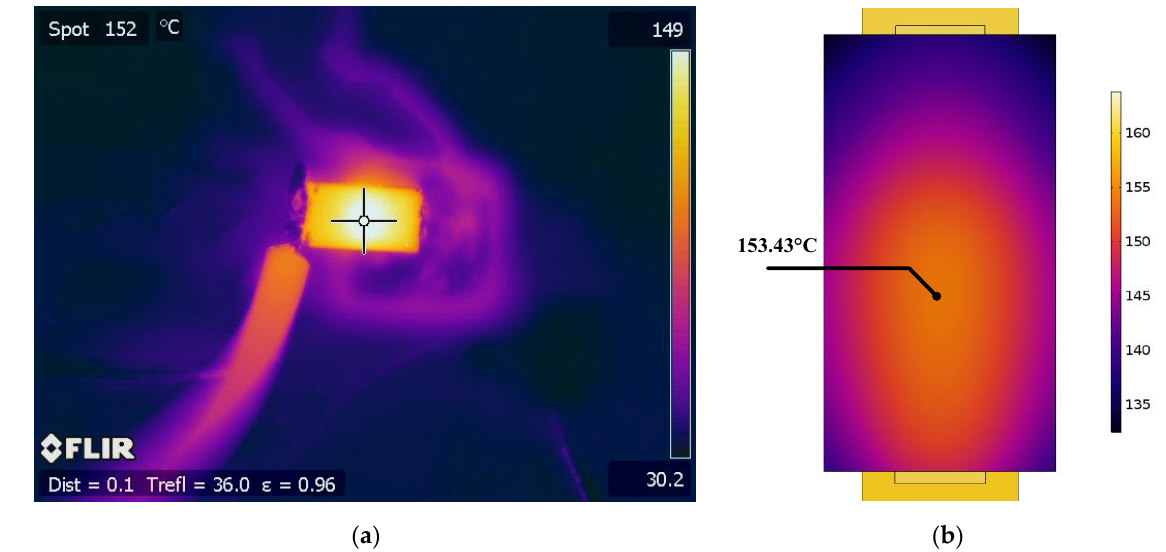
Figure 14. The Comparison for 410 (mA) forward current: ( a ) measurement; ( b ) simulation result. Because the operational maximum of selected power diode, from the thermal perfor- mance point of view, is defined as 150 ◦ C, the last experiment was realized for 500 mA. The temperature maximum is defined for the body of the diode; therefore, even though the temperature reached 152 ◦ C within the previous experiment, it must be noted here that the device temperature, considering the whole volume, is around 100 ◦ C.